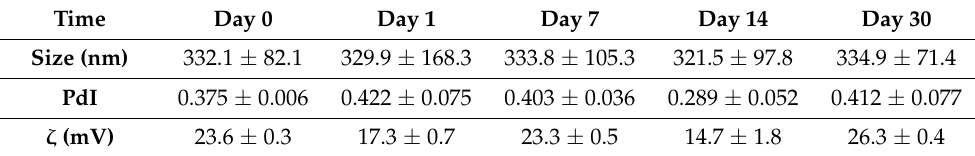
Table 1. Particle diameter (nm), PdI, and ζ values (mV) of the (core/shell)/shell NPs as a function of time (days). Data are expressed as means ± SDs of triplicate experiments. Time Day 0 Day 1 Day 7 Day 14 Day 30 Size (nm) 332.1 ± 82.1 329.9 ±